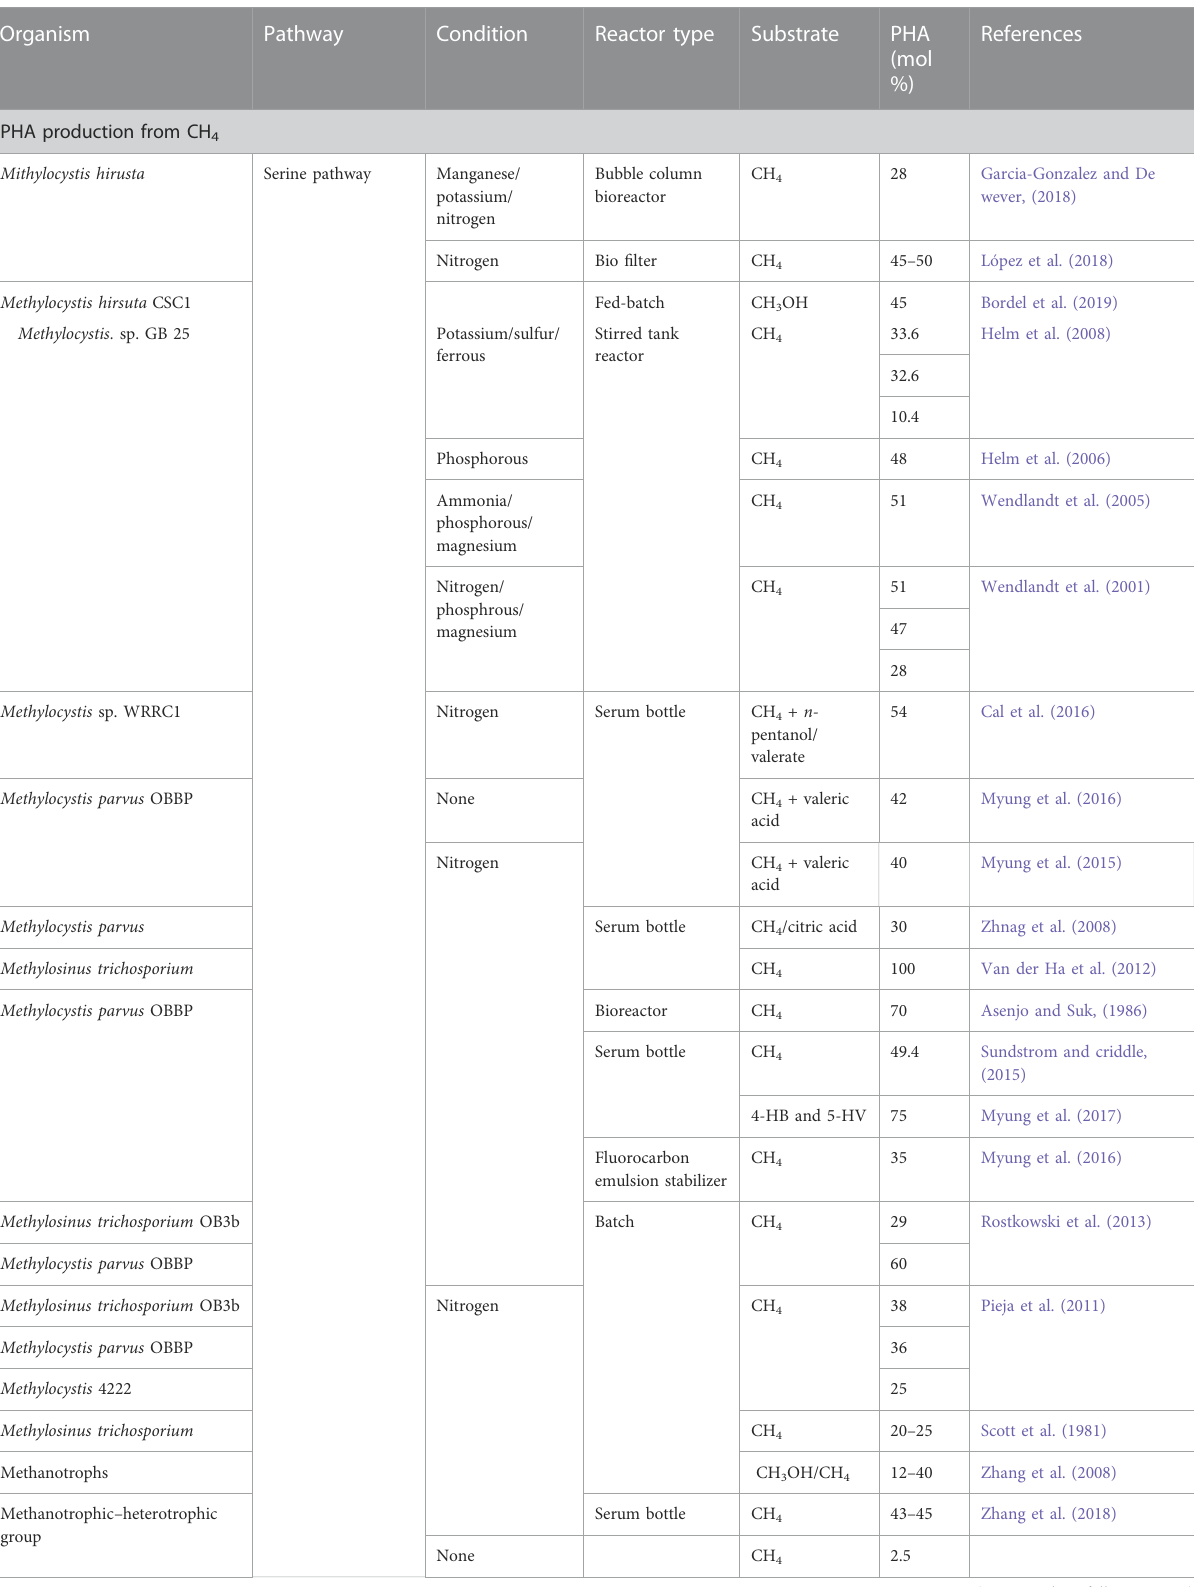
TABLE 2 Polyhydroxyalkanoate production from CH 4 and CH 3